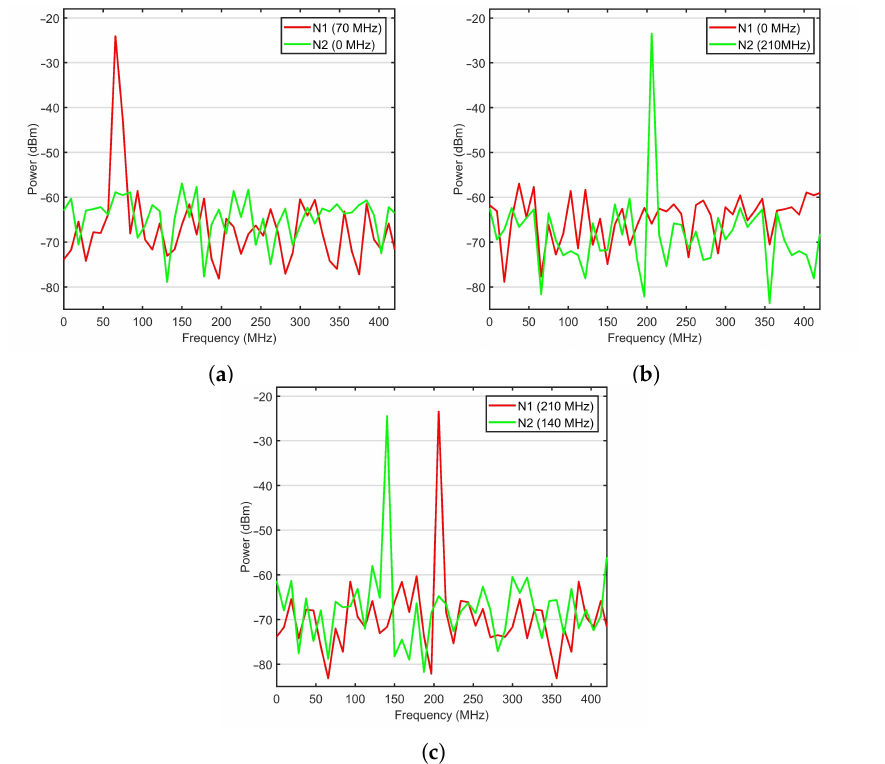
Figure 3. RF signal received from nodes N1 and N2 in experiments 1–3 ( a – c ) indicated in Table